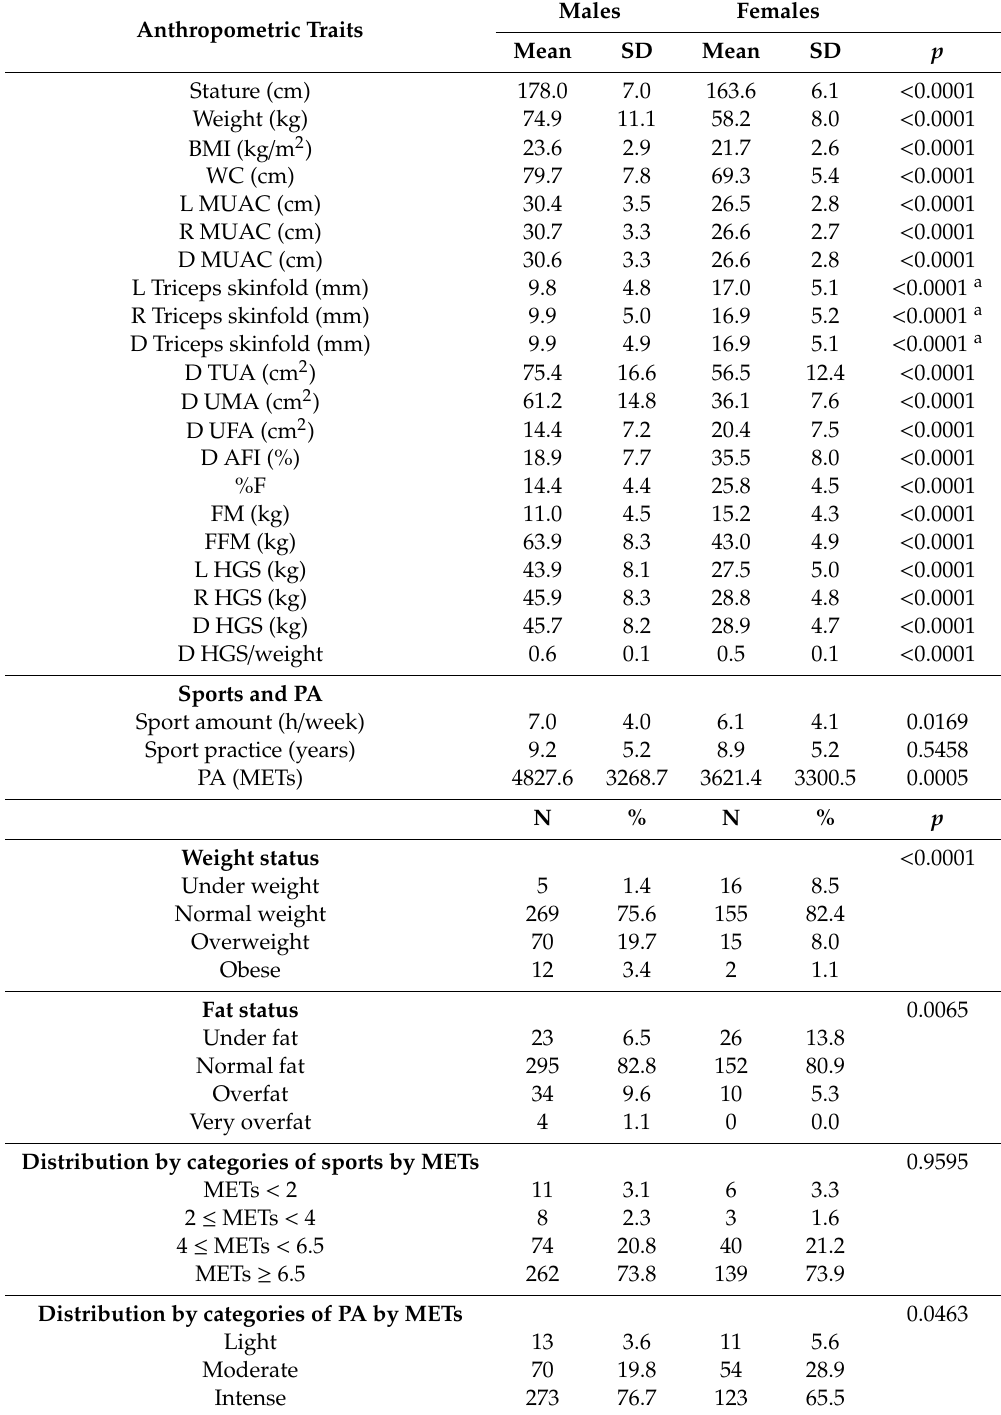
Table 1. Anthropometric characteristics, sports habits, and fat and weight status by sex (R = right; L = left; D = dominant